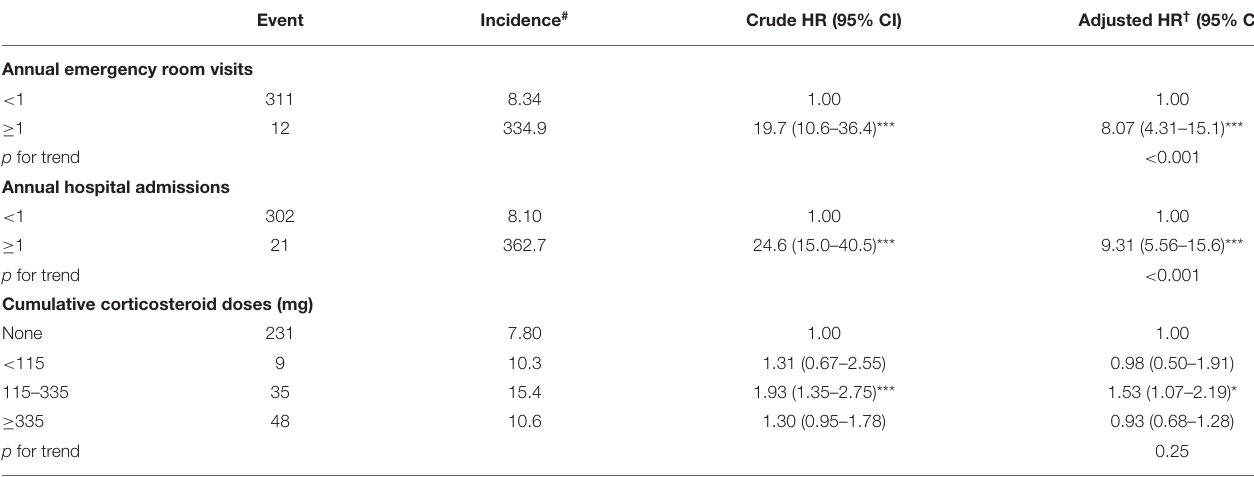
TABLE 4 | Incidences and hazard ratios of pleural empyema by emergency room visits, hospital admissions, and cumulative corticosteroid doses among asthma